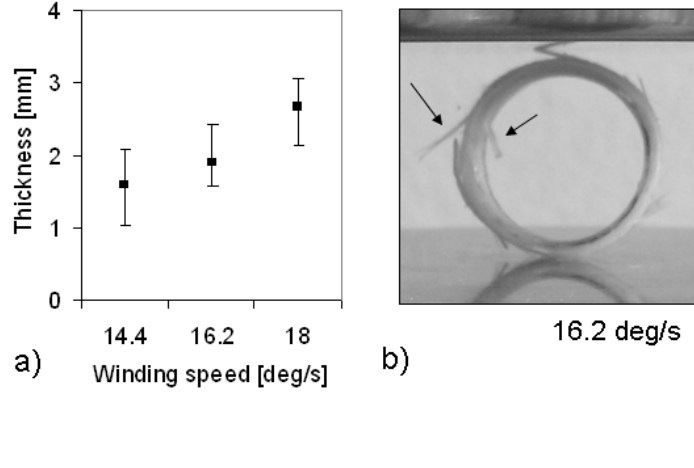
Figure 7. (a) Effect of the winding speed on the composite thickness and (b) appearance of a sample wound at 16.2